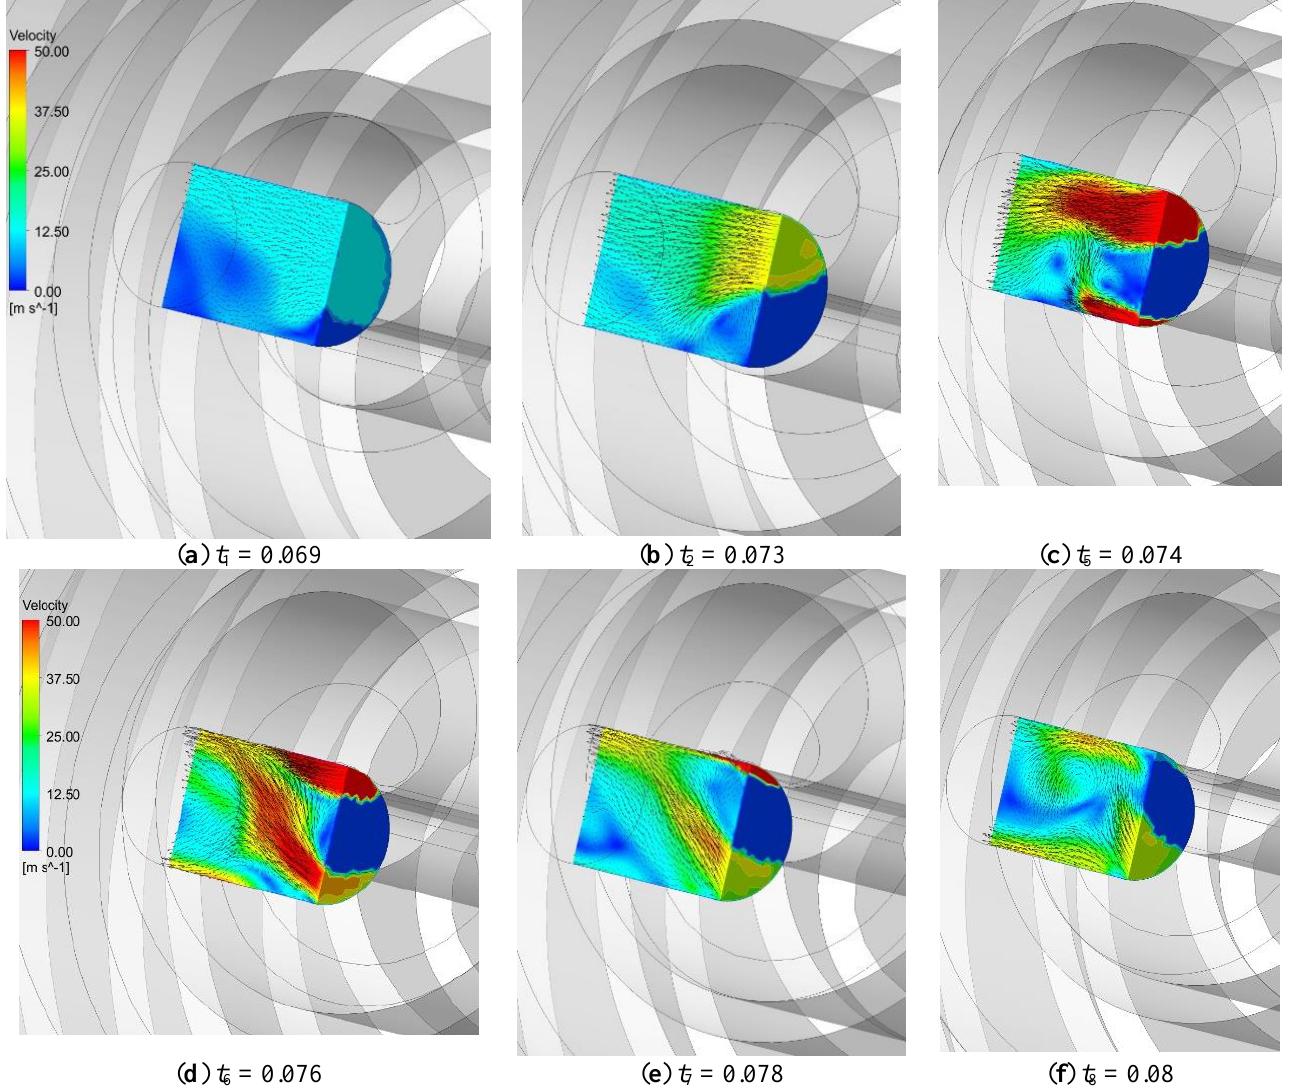
Figure 11. Vector plots of the flow field at the scroll discharge located on the discharge port (of circular shape) and on an axial section plan (rectangular shape) (CFX). The zero-velocity area on the discharge port is related to the width of the wall of the orbiting scroll, partially blocking the discharge area.